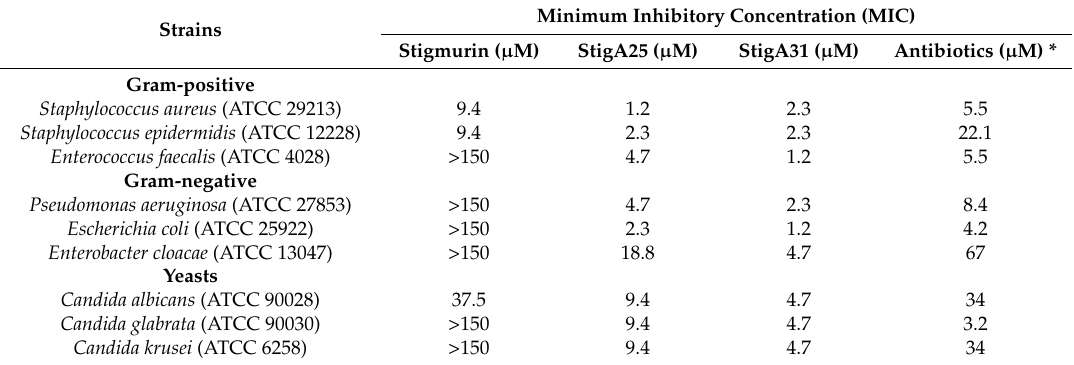
Table 4. Determination of minimum inhibitory concentrations (MICs) of Stigmurin, StigA25, and StigA31. Strains